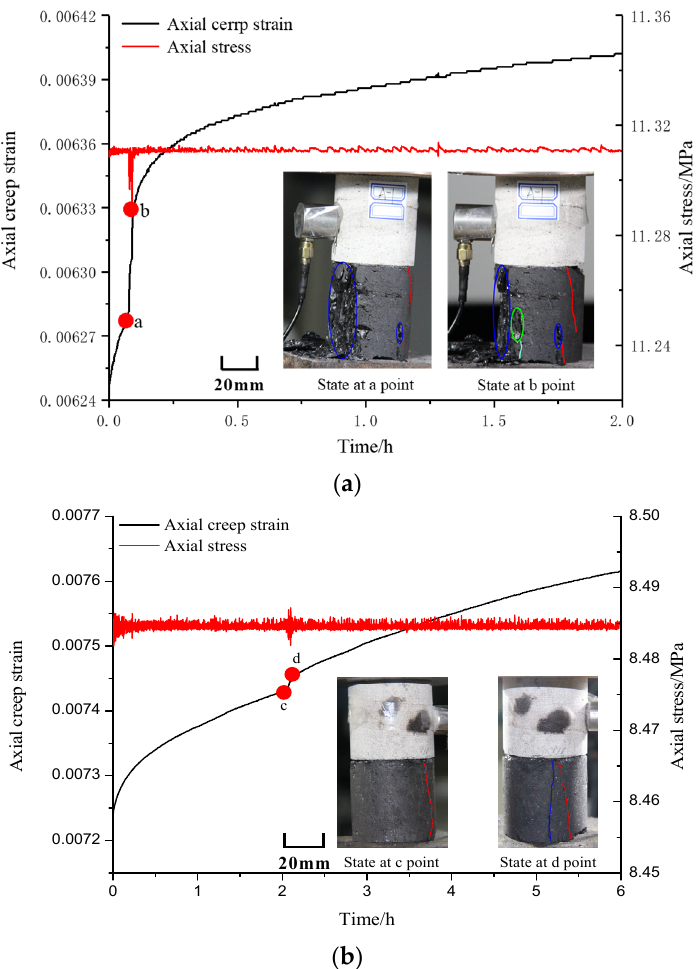
Figure 12. Axial creep strain fluctuations of sandstone-coal composite samples (the scale bar between the sample size in the figure and that of the real sample is 1:4): ( a ) Axial creep strain fluctuation of A-1 composite sample at the stress level of 11.31 MPa; ( b ) Axial creep strain fluctuation of B-3 composite sample at the stress level of 8.48